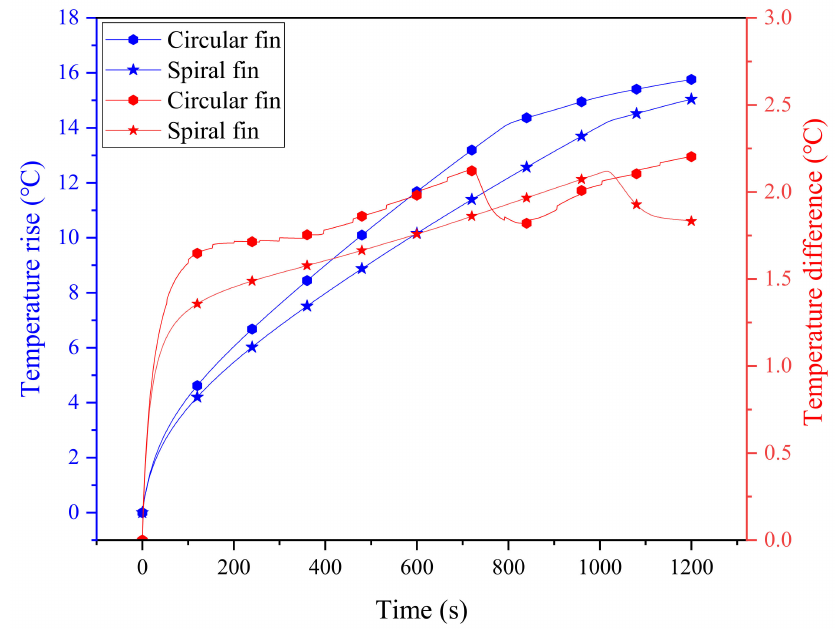
Figure 5. The evolution of temperature and temperature difference of two PCM-fin systems with circular and spiral fins.